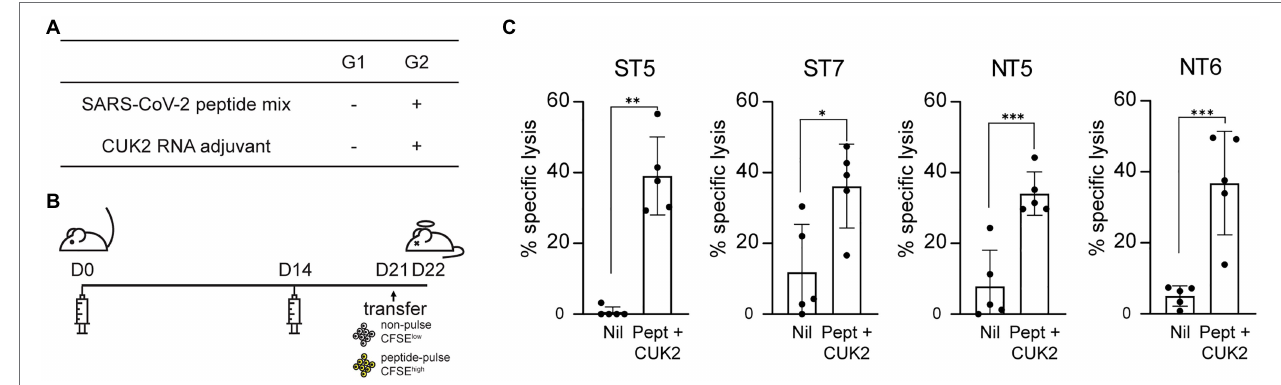
FIGURE 5 | Severe acute respiratory syndrome coronavirus 2 peptide-specific CTL responses in vivo . (A) Overview of the experimental groups. (B) Schedule of mice immunization. C57BL/6 mice were immunized twice at 2-week intervals with each SARS-CoV-2 peptides mixture+ CUK2 RNA adjuvant and killed 1 week